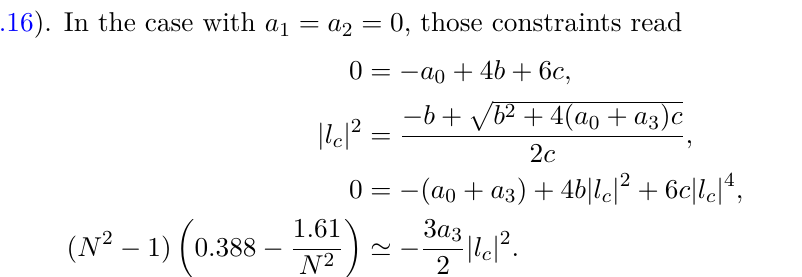
) for the confinement- c with the best fit parameters a = 4 . 95 , a = 0 , a = 0 , a = − 6 , c 0 1 2 3 1 . 5 c ≤ 4 c ≤